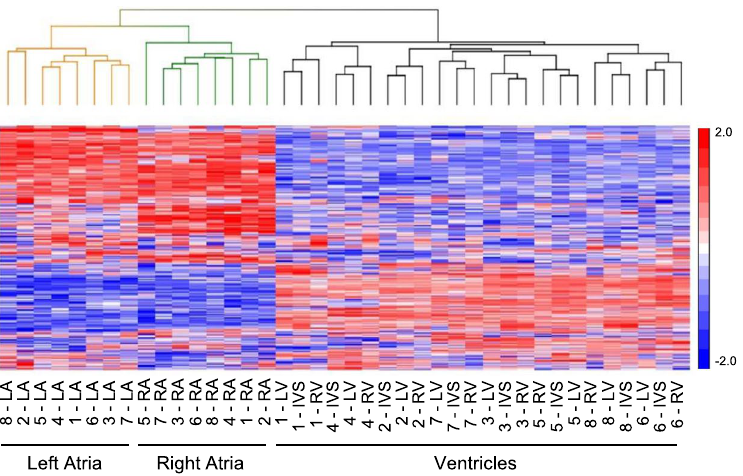
Figure 5. Differentially expressed lncRNAs distinguish non-failing human LA and RA. Unsupervised hierarchical clustering and heat map of the expression profiles of the top 100 (greatest difference) differentially expressed cardiac lncRNAs distinguish the LA (orange) from RA (green) samples, as well as from the LV, RV and IVS (black) samples. Normalized read counts were standardized so that the row mean was zero and the standard deviation was 1. Data ranges for higher (red) and lower (blue) expressed lncRNAs are